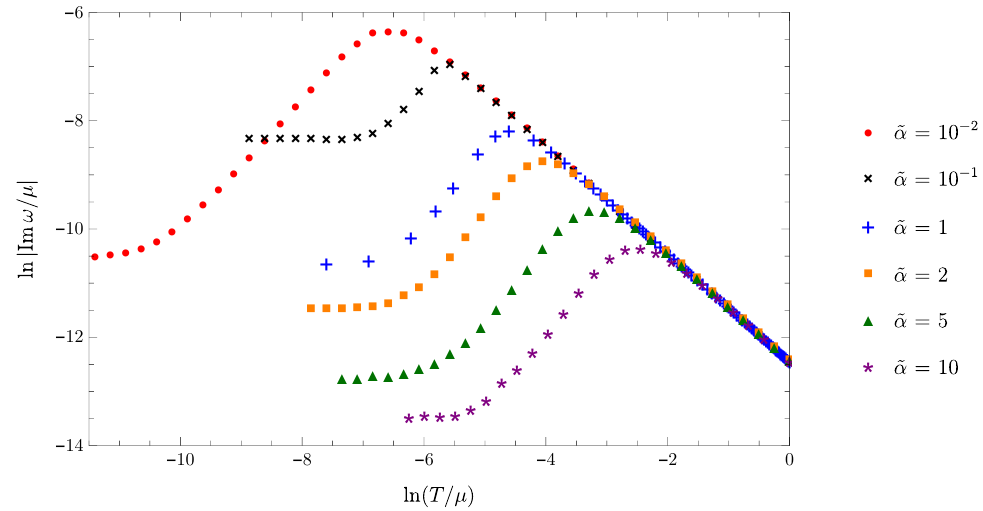
Figure 19. Our numerical results for ln j Im ( !=(cid:22) ) j versus ln ( T=(cid:22) ) for (cid:28) = 10 (cid:0) 4 , k=(cid:22) = 10 (cid:0) 2 , and ~ (cid:11) = 10 (cid:0) 2 (red dots), 0 : 1 (black crosses), 1 (blue plus signs), 2 (orange squares), 5 (green triangles), and 10 (purple stars). The ~ (cid:11) = 10 (cid:0) 2 curve di(cid:11)ers from the others at small T=(cid:22) because in that case relativistic poles rather than HZS cross over to hydrodynamic sound ((cid:12)gures 9c, 9d, 10c, and 10d). For all ~ (cid:11) , including ~ (cid:11) = 10 (cid:0) 2 , as ln ( T=(cid:22) ) increases, (cid:12)rst j Im ( ! ) j scales as T 0 , then as a power of T slightly less than T 2 , then has a maximum, and (cid:12)nally scales as T (cid:0) 1 . For ~ (cid:11) & 0 : 07, increasing ~ (cid:11) simply re-scales ln j Im ( !=(cid:22) ) j to smaller total value, without changing its shape, and shifts the maximum to higher T=(cid:22)